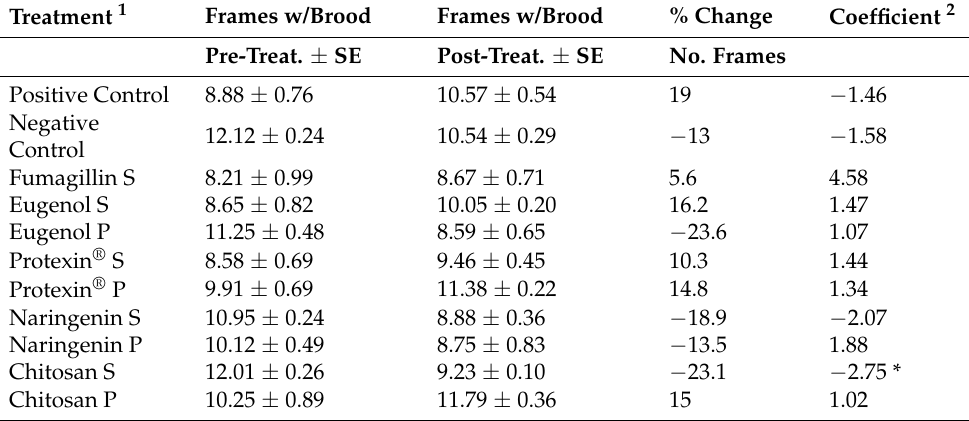
Table 2. Effect of spring 2017 treatments on number of frames containing brood per colony one–two days pre-treatment and nine weeks post-treatment with the antibiotic fumagillin, prebiotics eugenol, naringenin or chitosan, or probiotic Protexin ® . Coefficients indicate how the number of frames with brood changed relative to the positive control. Means are from six colonies per